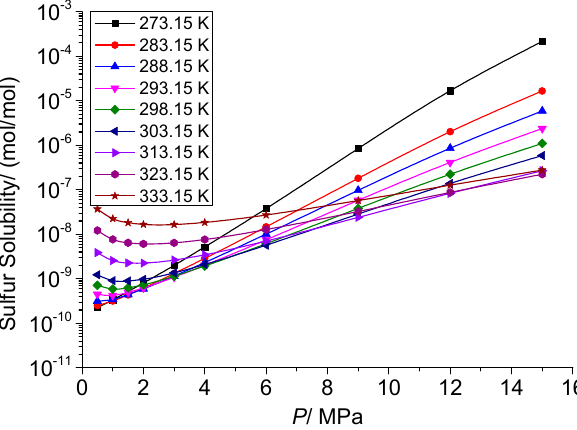
Figure 8. Total solubility of elemental sulfur in acid gas 3 as a function of pressure.